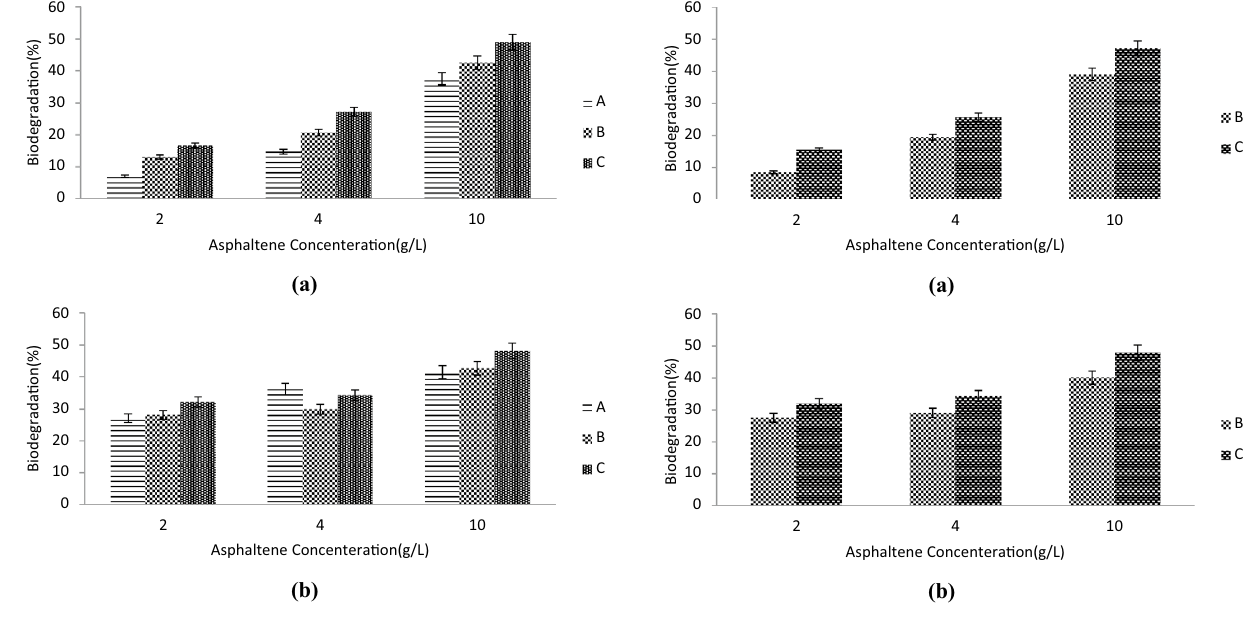
Fig. 6 Biodegradation of two types of microorganisms at different initial Kuh-e-Mond asphaltene concentrations: a without SDBS pres- ence and b with SDBS